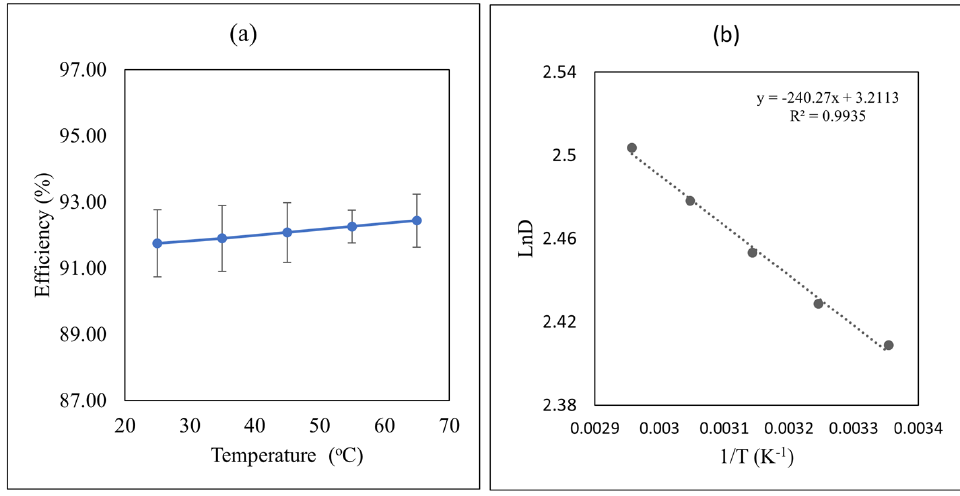
Figure 4. ( a ) Effect of the temperature on removal efficiency of oil by IL4. Initial oil concentration = 500 mg/L, contact time = 4 min, pH = 8 phase ratio (PW:IL) = 4:1,with σ = ±3.24 × 10 − 1 %, ( b ) Van’t Hoff plot for oil extraction from PW using IL4. Initial oil concentration = 500 mg/L, contact time = 4 min, pH = 8 phase ratio (PW:IL) = 4:1 and temperature = 25 °C.